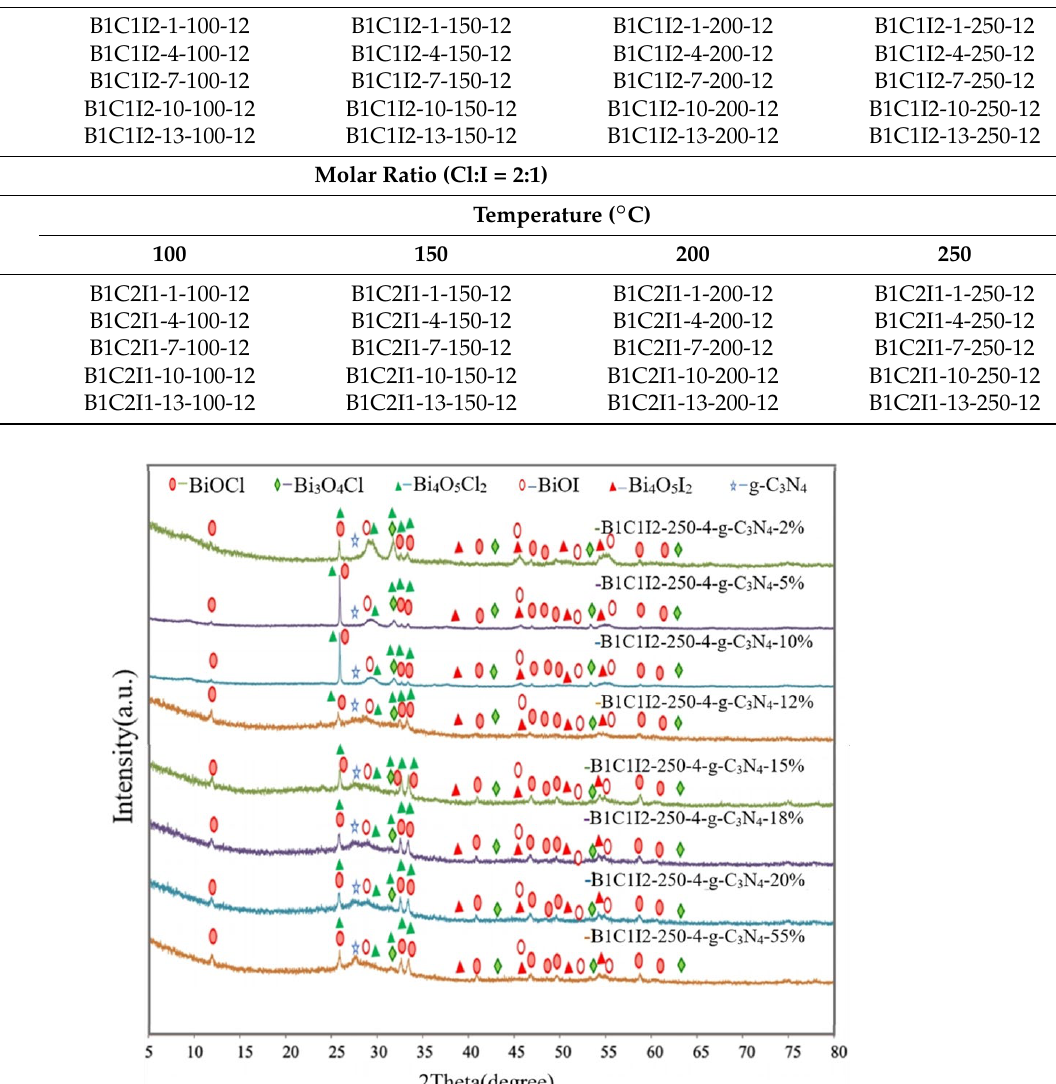
Figure 1. X-ray diffraction (XRD) patterns of the BiO m Cl n /BiO p I q /g-C 3 N 4 samples with g-C 3 N 4 con- tents of 2%, 5%, 10%, 12%, 15%, 18%, 20%, and 55% that were prepared under a KCl:KI molar ratio of 1:2, a hydrothermal temperature of 250 °C, a pH of 4, and a reaction time of 12